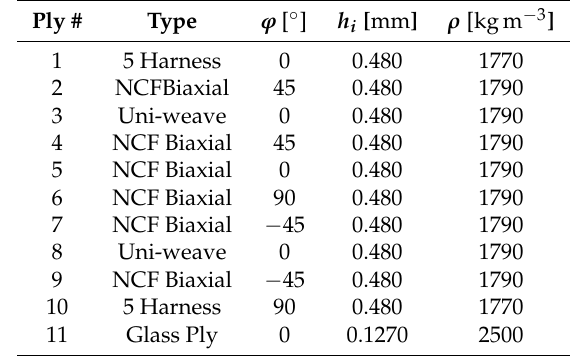
Table A1. Stacking sequence of a CFRP plate. Angle ϕ defines the in-plane rotation of the ply with respect to the global coordinate system (first Euler angle). The total thickness of the plate is 4.3mm.